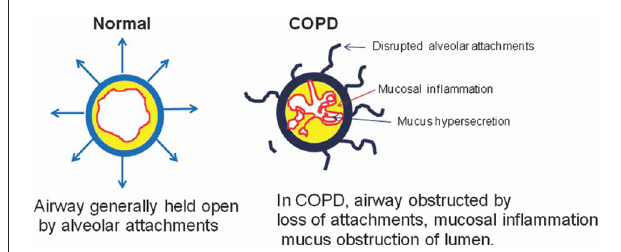
FIGURE 1 | Air flow in Normal vs. COPD. The airway in normal condition is distended by alveolar attachments at the time of expiration. But in COPD these alveolar attachments are mainly disrupted due to emphysema, therefore contributing to airway closure during expiration, and hyperinflation due to air trap in the alveoli. Inflammation, fibrosis and mucus secretions further obstructed and distorted the peripheral airways and consequently create the poor mucociliary clearance (Barnes,